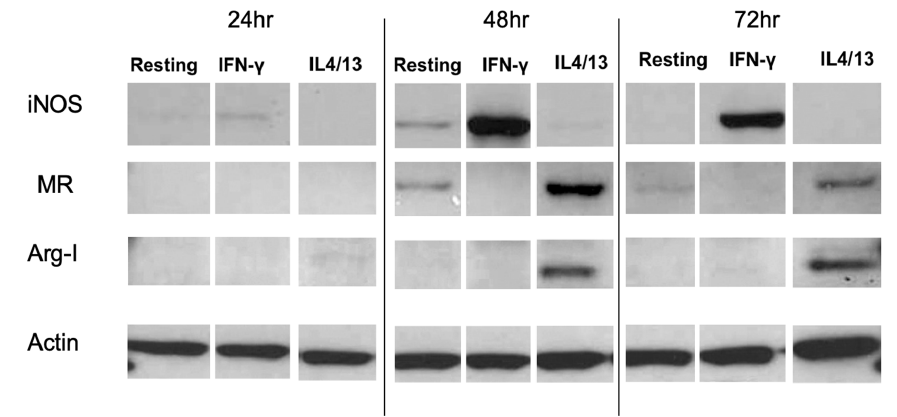
Figure 3. Time course of protein expression levels of the M1 marker iNOS, the M2 markers Arg-1 and MR, and the housekeeping protein actin in activated MPs. Western blot was performed using cell lysates from activated MPs. IFN- γ -treated MPs expressed high levels of iNOS protein at 48 and 72 h, while untreated resting and IL-4/IL-13-treated MPs expressed no or low levels of iNOS protein at 48 and 72 h. Conversely, IL-4/IL-13-treated MPs expressed high MR and Arg-1 levels at 48 and 72 h, while the IFN- γ -treated MPs expressed no or low levels of MR and Arg-1 proteins. The result shown represents one of the independent experiments.